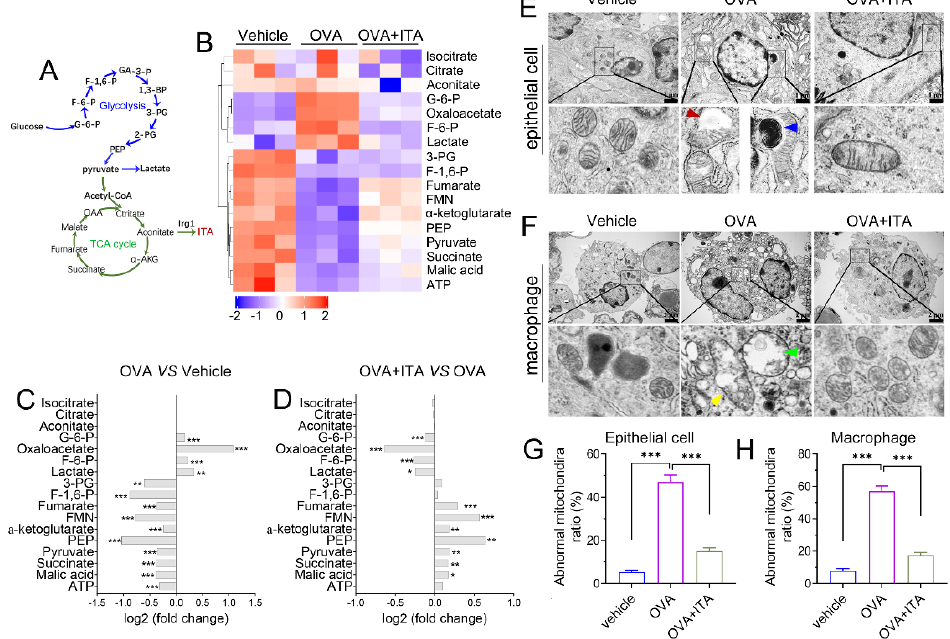
Figure 6. Itaconate regulates energy metabolism and mitochondrial morphology in allergic airway inflammation. ( A ) Schematic overview of metabolites involved in glycolysis and TCA cycle. ( B ) Heatmap showing relative levels of glycolysis and TCA cycle intermediate metabolites in vehicle, OVA and OVA+ITA group (three mice per group). ( C ) Fold change of glycolysis and TCA cycle metabolites in OVA group as compared with vehicle group. ( D ) Fold change of glycolysis and TCA cycle metabolites in OVA+ITA group as compared with OVA group. ( E ) Representative lung section showing mitochondrial morphological changes in epithelial cells. Scale bar: 1 µm. ( F ) Representative lung section showing mitochondrial morphology changes in lung macrophages. Scale bar: 2 µm. ( G , H ) The rates of abnormal mitochondria in epithelial cell and macrophage from vehicle, OVA and OVA+ITA group. Red arrowhead indicates cavity formation, blue arrowhead indicates black dense compact, yellow arrowhead indicates crista loss and rupture and green arrowhead indicates swelling. Data expressed as means ± SEM ( n = 3). * p < 0.05, ** p < 0.01, *** p < 0.001.